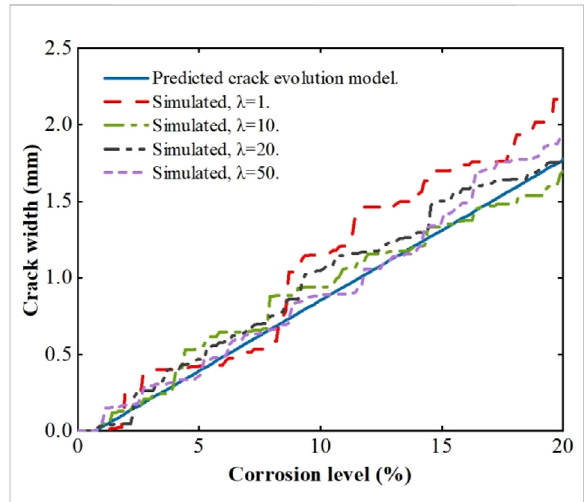
FIGURE 6 Simulated concrete crack growth process by gamma sequence sampling (GSS) with various values of scale parameter λ , compared with the predicted concrete crack width evolution.